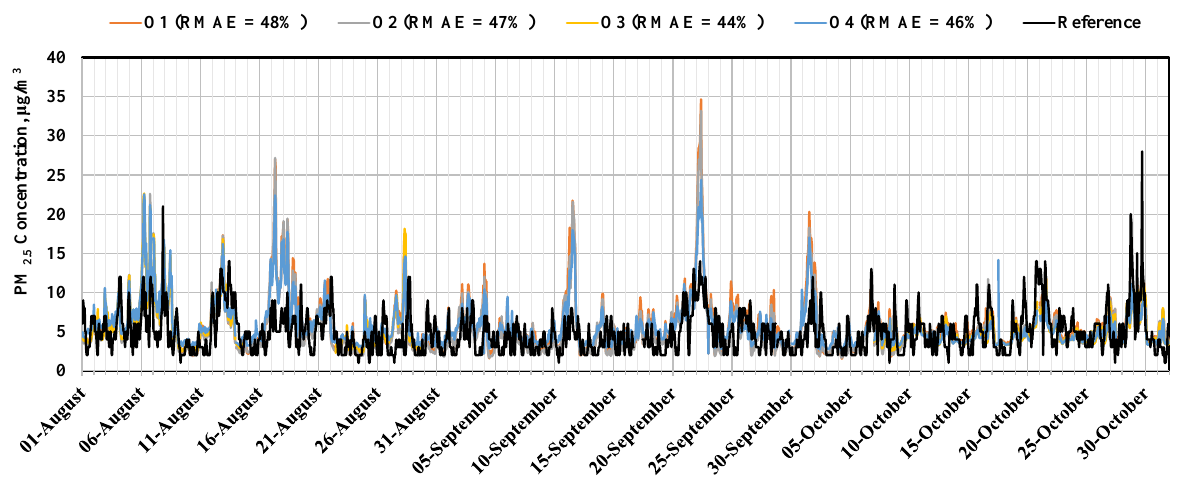
Figure 9. PM 2.5 measurements based on AirSENCE™ and reference measurements for the period between August 1 and October 31,